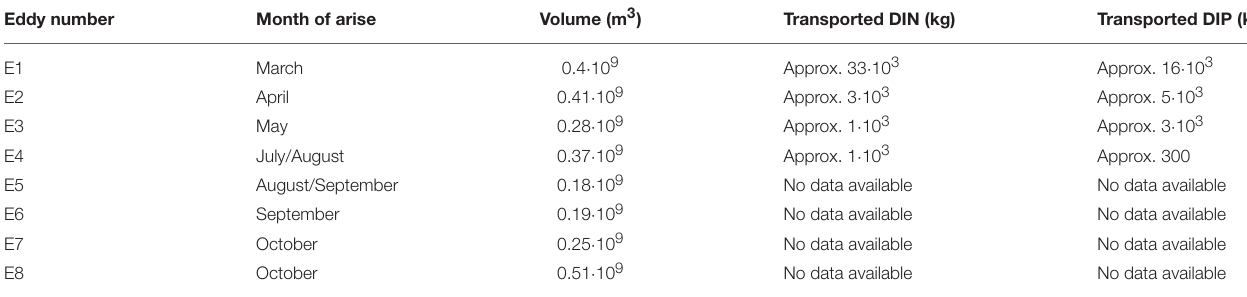
TABLE 2 | Transported volume and amount of DIN and DIP of eddies with transporter properties. Eddy